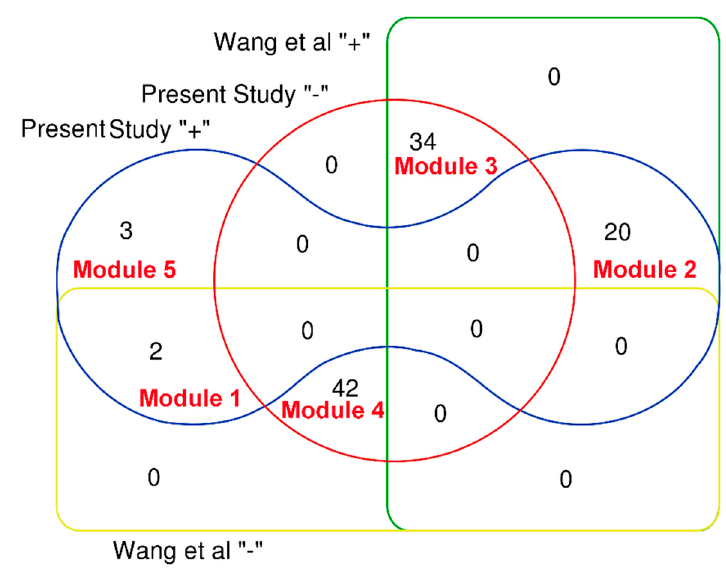
Figure 7. Venn diagram to show a comparison between the computational toxicology approach and the prior study. Prsent “ + ” and Prsent “ − ” indicate that the compound was predicted as hepatotoxic or non-hepatotoxic by our computational toxicology approach, respectively. Wang “ + ” and Wang “ − ” represent that the compound was identified as hepatotoxic or non-hepatotoxic by Wang et al, respectively. Ingredients included in each module are available in Supplementary File 1 (PmT).